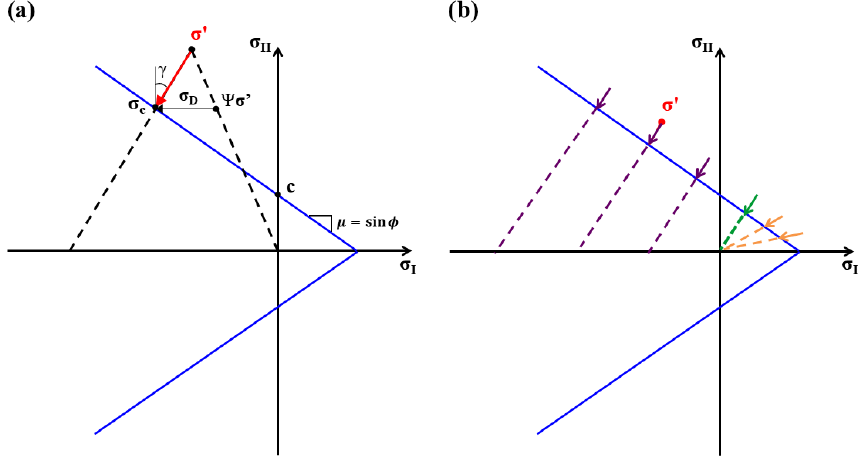
Figure 1. (a) Mohr–Coulomb yield criterion ( ± σ II + µσ I = c , blue lines) in stress invariant space. σ (cid:48) is the uncorrected super-critical stress state, σ c is the critical stress state for a given correction path angle γ (red dashed line) and c is the cohesion. The decohesive stress tensor σ D is defined as the difference between σ c and the scaled super-critical stress ( (cid:57) σ (cid:48) ). (b) Proposed correction paths for various super-critical stresses σ (cid:48) that minimize the error amplification ratio ( R ), which consist of the standard parameterization for large tensile stresses (orange) and a correction path with γ = 45 ◦ for small tensile and compressive stresses (purple). The green line indicates the transition between the two